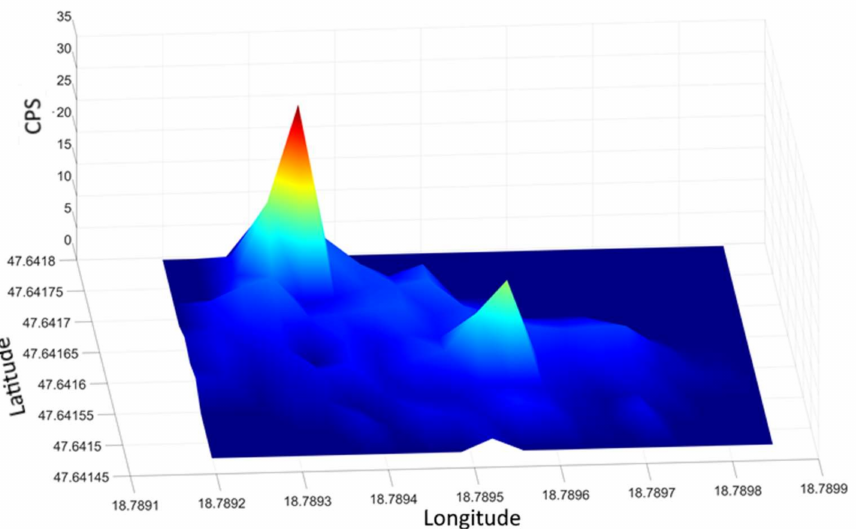
Figure 13. 3D display of the data from the dual-source survey, where the altitude is proportional to the count per second (CPS). In the figure, the data were corrected using the average value of the background radiation, thus there are extra detection values along the “Z” axis compared to the